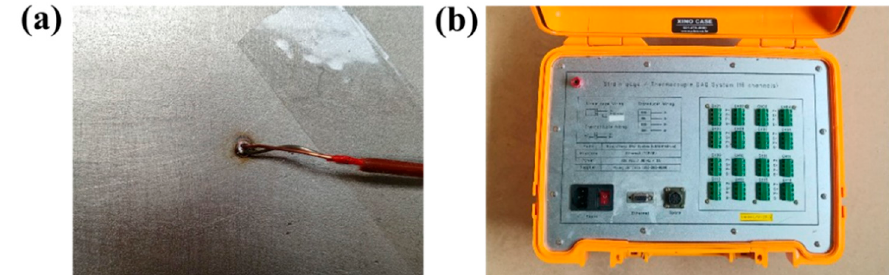
Figure 2. Data acquisition apparatus to measure inner tank surface temperature ( a ) Spot welding of thermal couple ( b ) data acquisition system